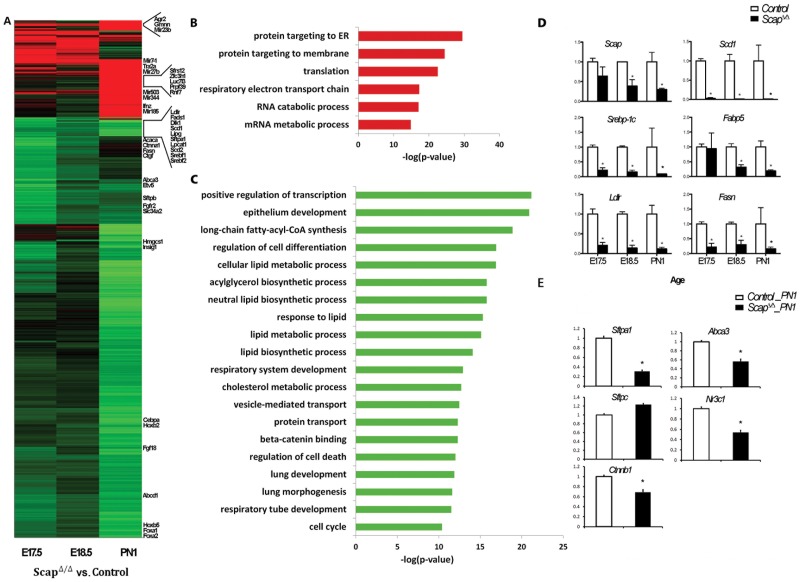
Genes and biological processes affected by Scap deletion in the developing lung.A) Differentially expressed genes in ScapΔ/Δ lungs were identified by mRNA microarray analysis. Heatmap analysis shows the two-dimensional clustering of 1079 mRNAs that were significantly altered in ScapΔ/Δ mice compared with controls. The intensity in the red and green color ranges indicates increased versus decreased mRNAs, respectively. Each row represents a single mRNA, and each column represents an average fold change between knockout and control mice at the specified gestational age. B and C) Biological processes significantly influenced by epithelial Scap deletion were identified using ToppGene Suite (http://toppgene.cchmc.org). Enriched bioprocesses in genes induced (B) or suppressed (C) in ScapΔ/Δ lungs are represented as red bars and green bars respectively. Statistical significance of each bioprocess was presented using negative log2 transformation of P value. D and E) qPCR analysis confirmed RNA microarray data demonstrating altered expression of genes involved in lipid biosynthesis/transport (D) and in lung development and maturation (E) in ScapΔ/Δ mice (filled bars) compared with control (open bars), n = 3/group, *p<0.05.